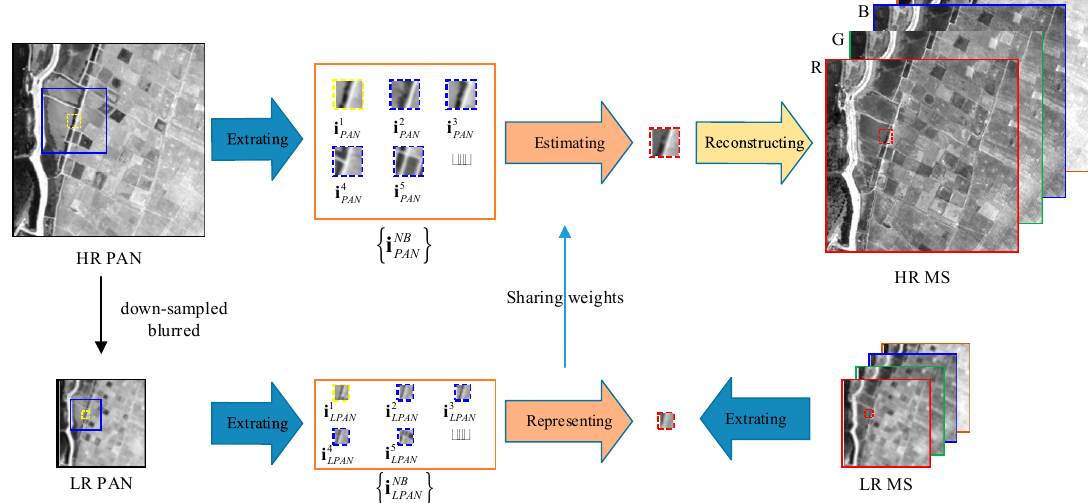
Figure 4. The flowchart of the proposed spatial weighted neighbor embedding (SWNE) method. The proposed method consists of five steps: (1) Produce LR panchromatic (PAN) image from HR PAN image; (2) Divide the images into patches; (3) Find the neighbors from LR PAN patches of target LR MS patch; (4) Estimate the weight of each neighbor; (5) Multiply these weights with the corresponding HR PAN patches to reconstruct HR MS patch.